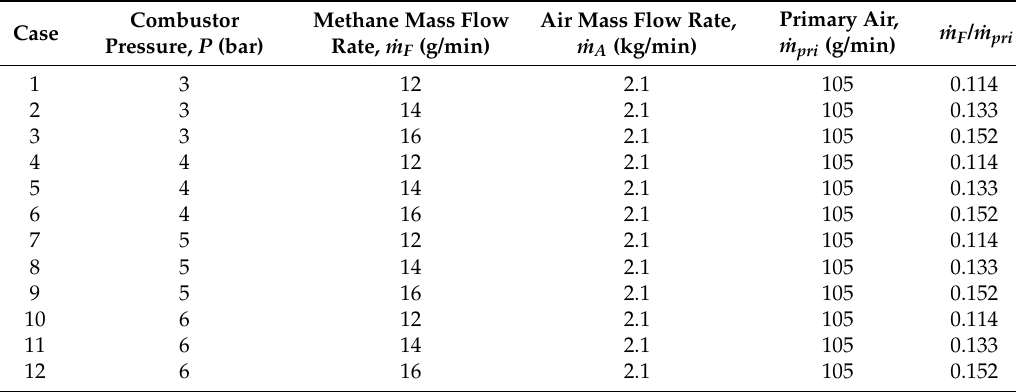
Table 2. Operating conditions of the